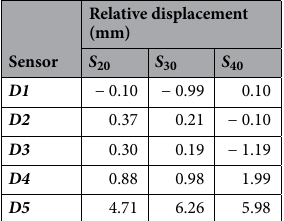
Table 2. Displacement of the slopes after step 5 loading. Note that the S 20 and S 30 slopes were subjected to eight loading stages, whereas the S 40 slope was subjected to four loading stages.